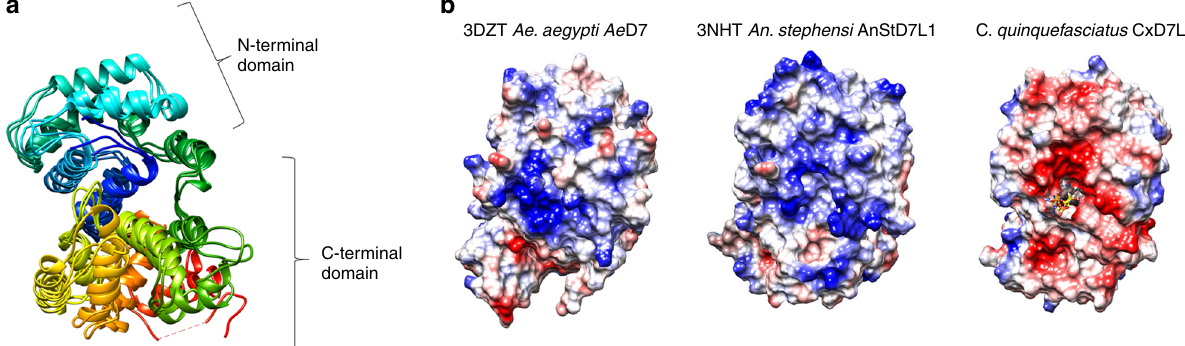
Fig. 5 Multiple sequence superposition and electrostatic potential of Culex D7 proteins. a Superposition of CxD7L1, Ae. aegypti AeD7 (PDB ID: 3DZT) and An. stephensi AnStD7L1 (PDB ID: 3NHT) shows a similar overall helix structure. Rainbow coloring pattern shows the N-terminal in blue and the C-terminal in red. b Electrostatic potential of 3DZT, 3NHT, and CxD7L1 generated by Coulombic Surface Coloring (Chimera software) with blue being positive and red being negative. ADP is represented as a stick